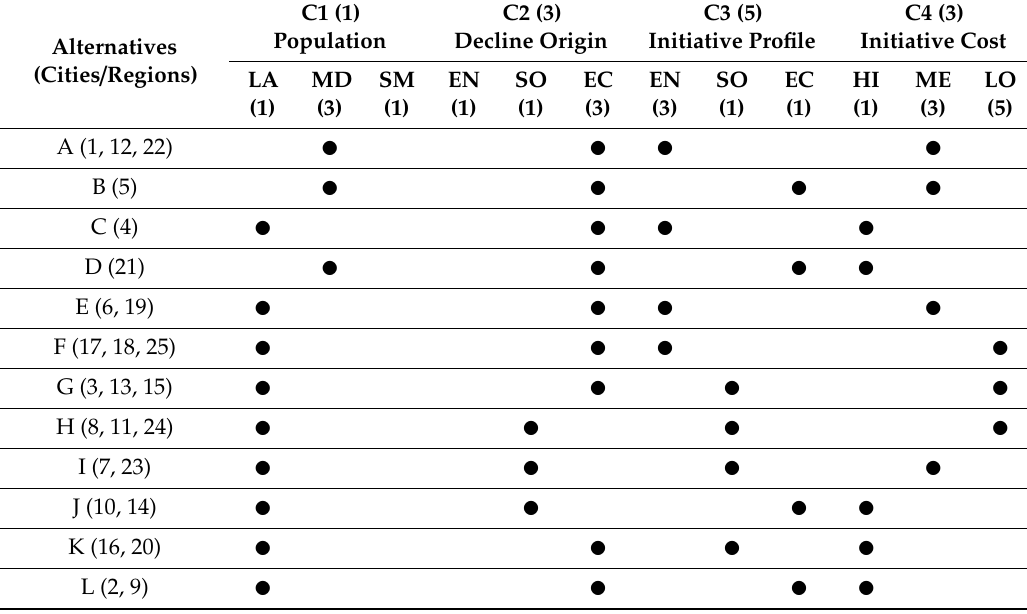
Table 3. Influencing factors (criteria C1–C4), initiatives (alternatives A–L), and relative importance (1–5).